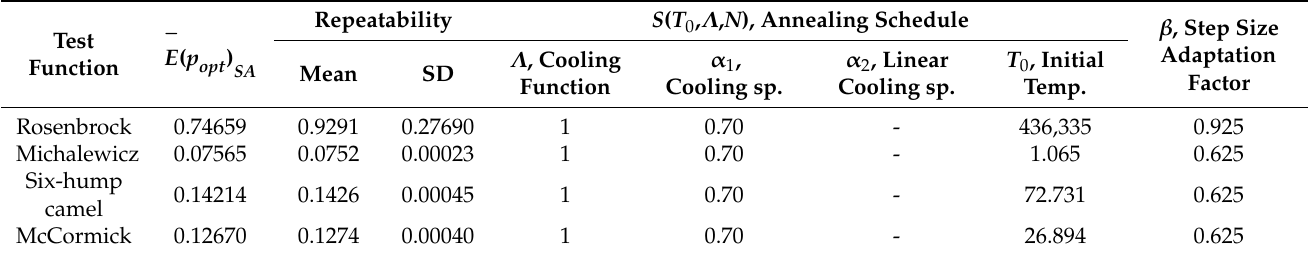
Table 6. Optimal parameter settings for different mathematical test